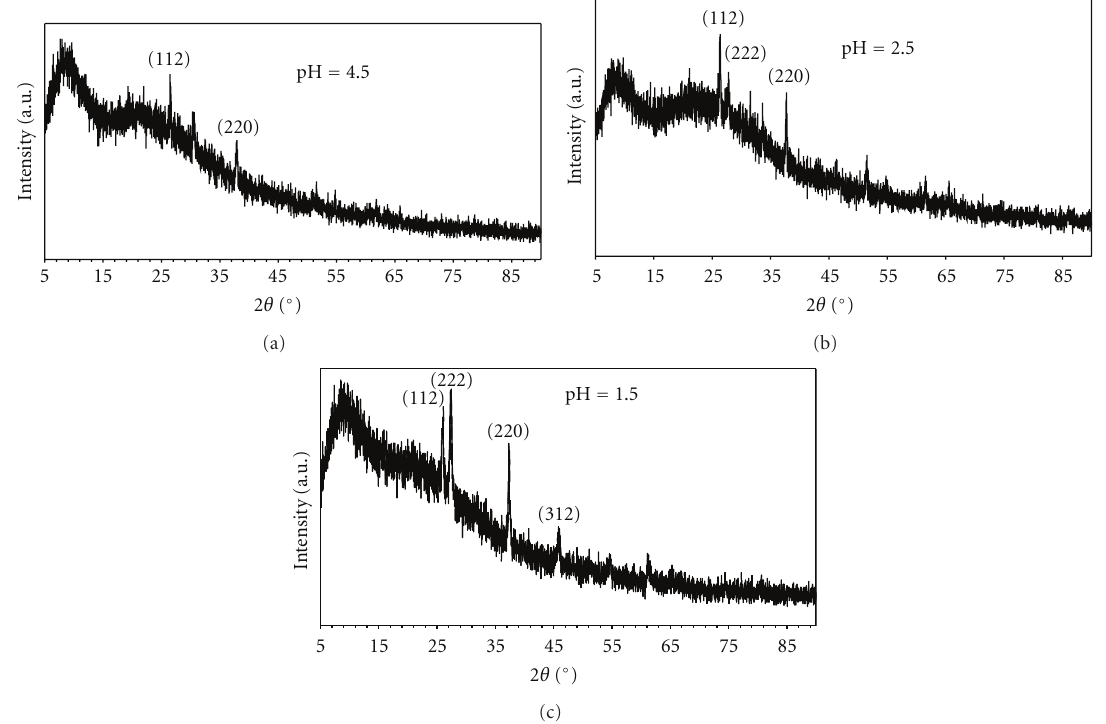
Figure 3: XRD patterns of CuInS 2 compounds electrochemical deposited at − 1.0 V from solution containing 5mL of 0.1 M copper chloride, 5mL of 0.1 M indium chloride, and 150 mL of sodium thiosulphate at di ff erent pHs. Table 1: Atomic compositions obtained for the electrochemical deposited films at − 1.0V at di ff erent pHs from a solution containing 5